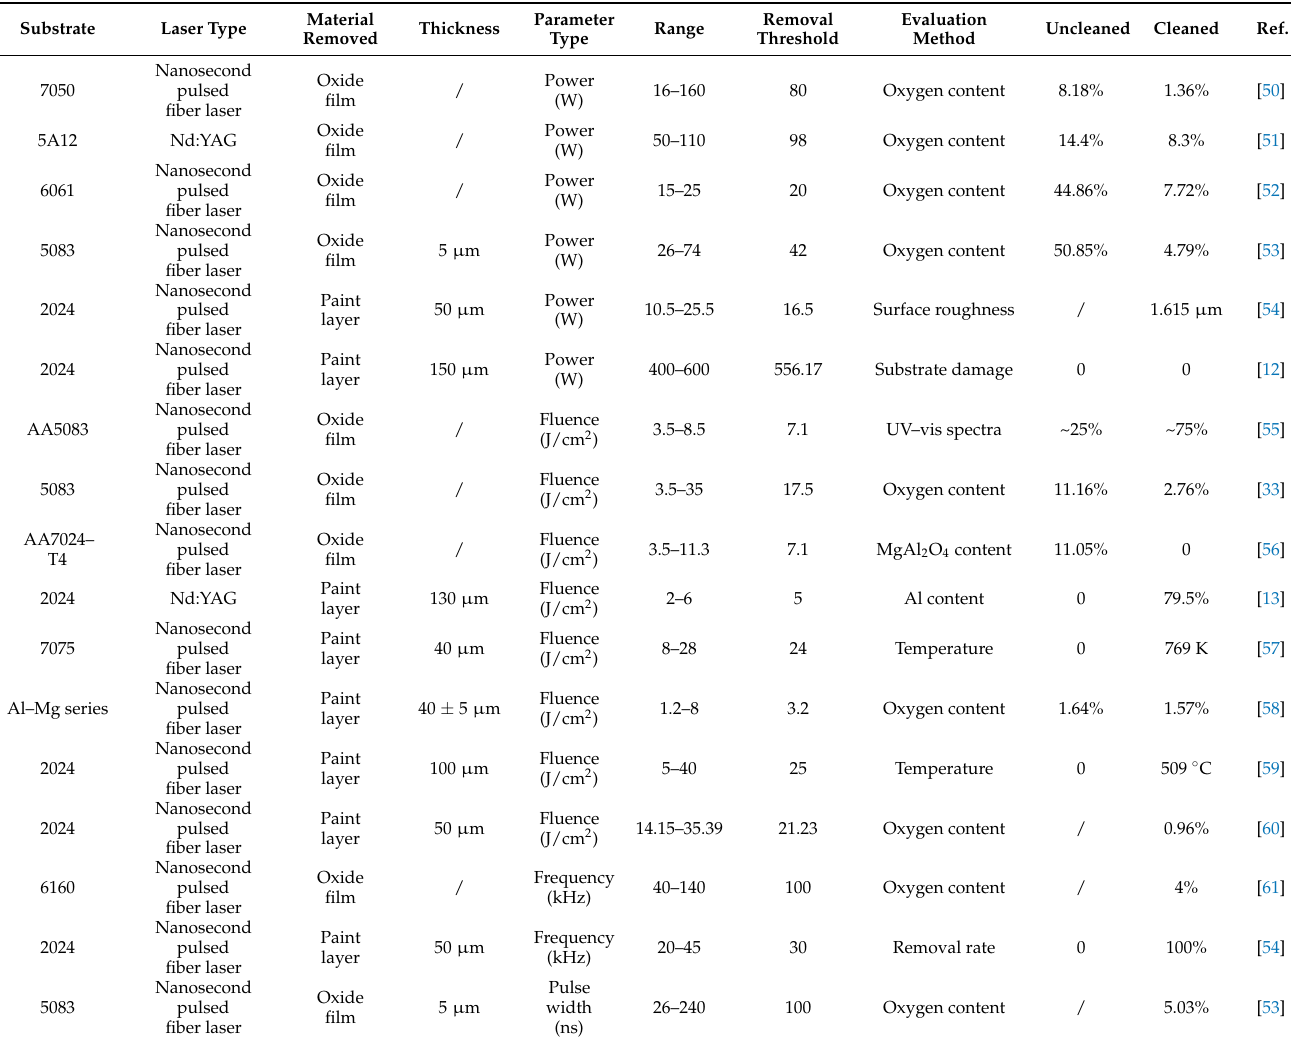
Table 1. Optimization of laser beam